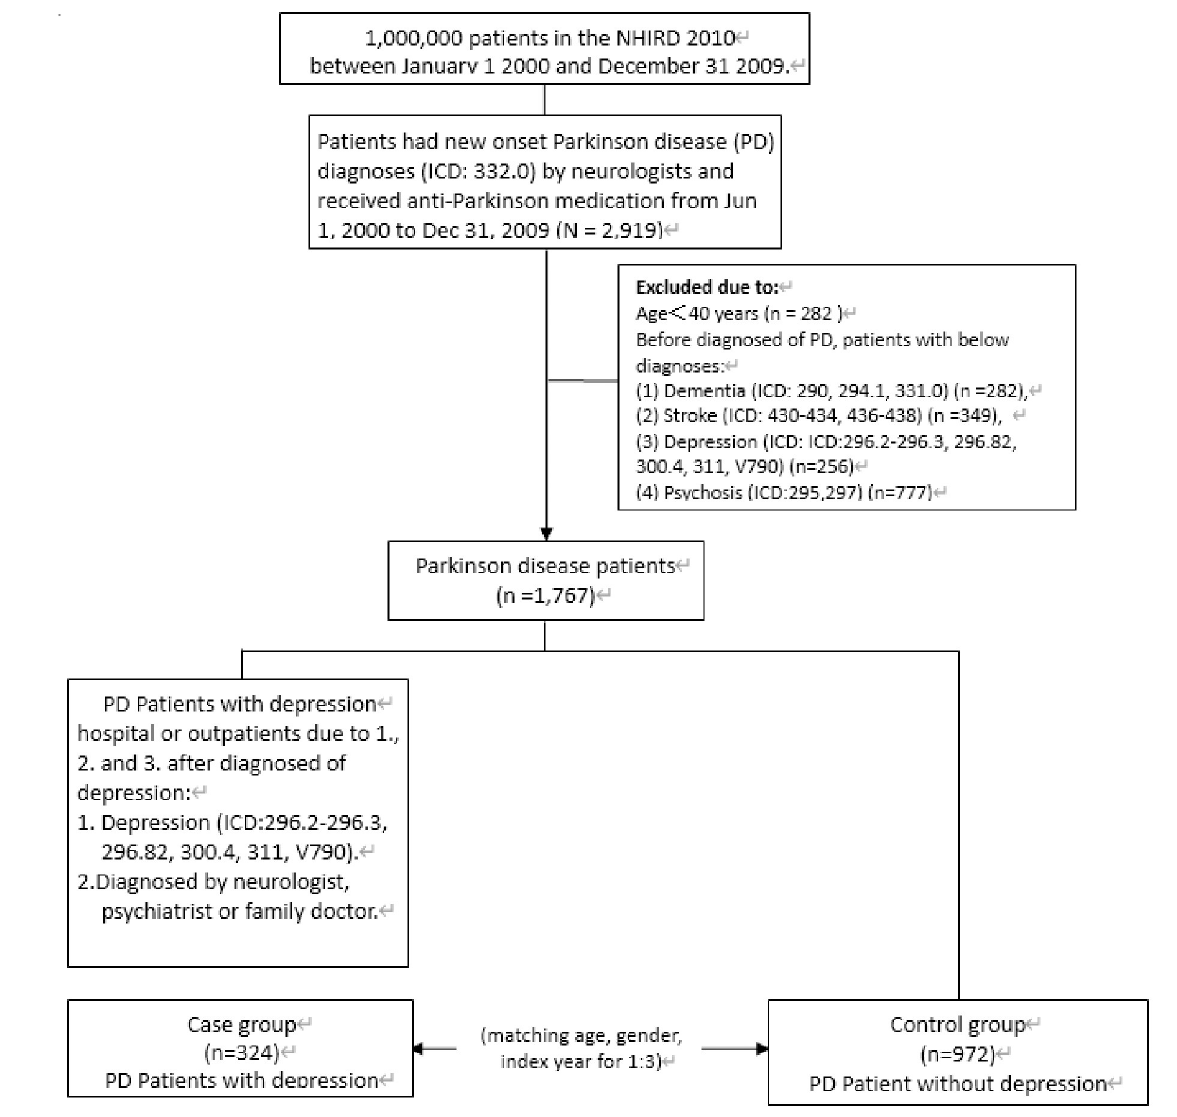
Fig 1. Flowchart of the nested case-control study from prescriptions in the 2000–2010 Taiwan National Health Insurance Research Database. Abbreviations: PD, Parkinson Disease; NIHRD, National Health Insurance Research Database; ICD, International Classification of Diseases. they were frequency-matched with cases at a ratio of 1:3 based on age, sex, and index year (Fig 1). In our study, the mean (SD) follow-up times after PD was 4.5 (3.0) years. Table 1 shows the distribution of sociodemographic characteristics and coexisting medical conditions of the cases and controls. A significantly higher percentages of cases had anxiety disorders (36.1% vs. 28.2%, P = 0.007) and sleep disturbances (38.9% vs. 31.0%, P = 0.009) compared with controls. The differences between cases and controls were nonsignificant for the other coexisting medi- cal conditions and all sociodemographic characteristics. Table 2 lists the adjusted odds ratios (adjusted ORs) for depression in the study patients. After adjusting for age, sex, index year, geographic region, urban level, monthly income, emer- gency visits before PD diagnosis, PD with dementia, the Charlson Comorbidity Index score, and other comorbidities, anxiety disorders and sleep disturbances were the only two factors